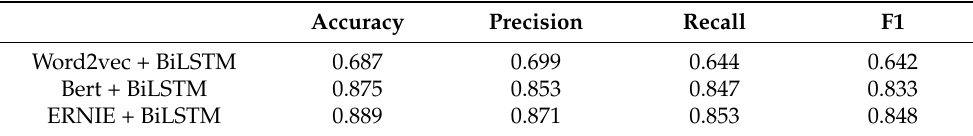
Table 5. Performance Comparison of Different Word Vector Models.